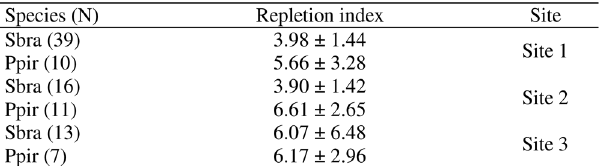
Table 3. Mean repletion index obtained for the two serrasal- min species of the rio de Contas, Bahia, collected at different sampling sites between May 2001 and April 2002. Values are the mean ± standard deviation.